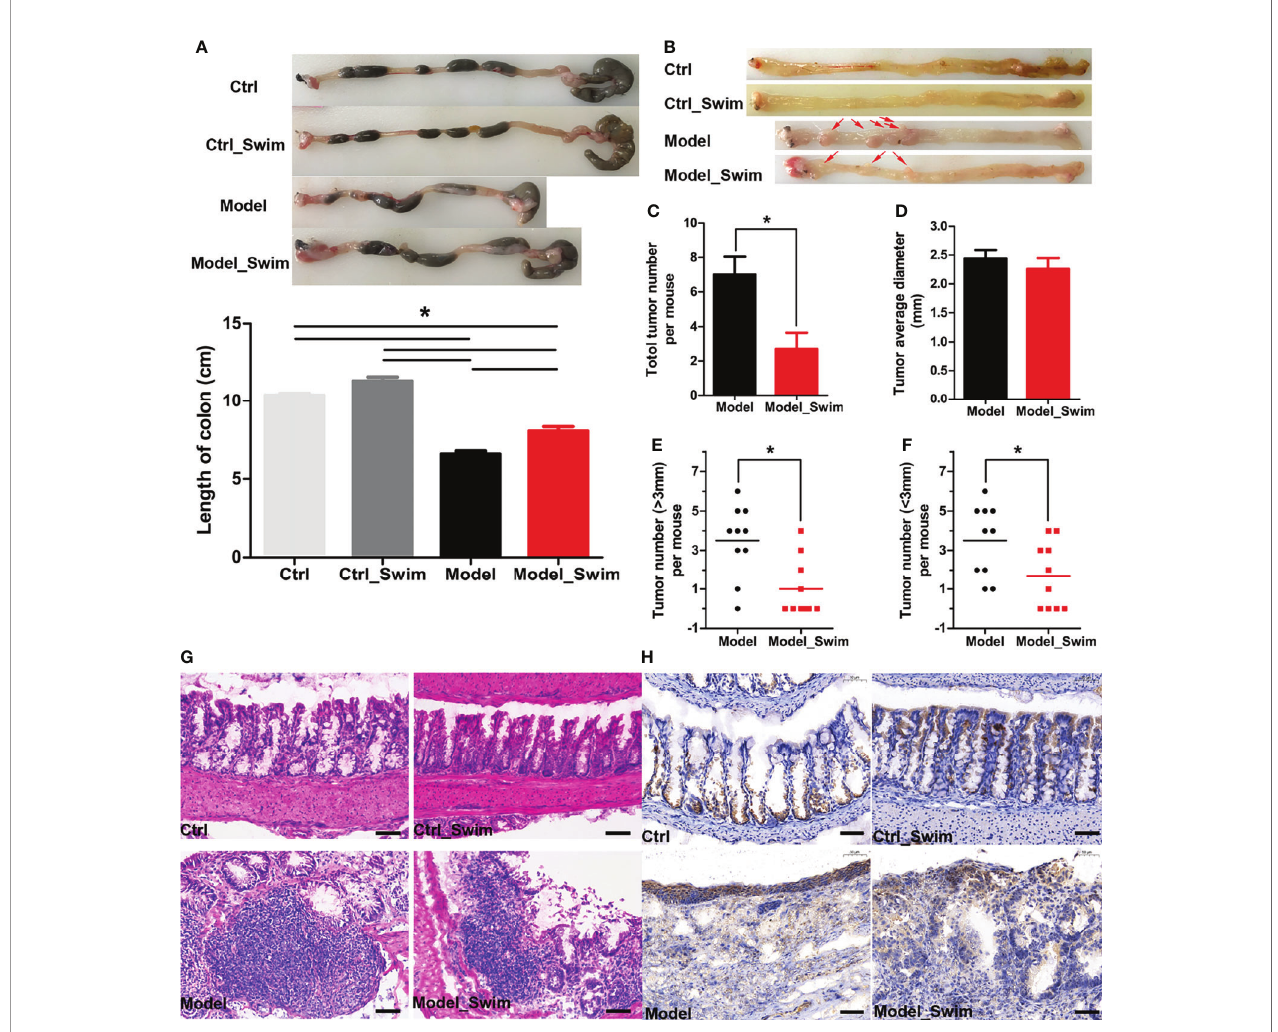
FIGURE 2 | Pretreatment with swimming alleviates colitis and tumorigenesis in AOM/DSS-induced CAC mouse models. (A) Representative images for both colon morphology and colonic length statistics. (B) Representative macrographic impressions. Remarkable red arrows represent tumors larger than 1 mm diameter. (C – F) Tumor morphology, tumor diameter and tumor distribution statistics. (G) The representative colonic H&E section. (H) Stained immunohistochemically by Cyclooxygenase-2 (COX-2). Results were presented by mean ± SEM. *P < 0.05, compared with Model group. Original magni fi cation,